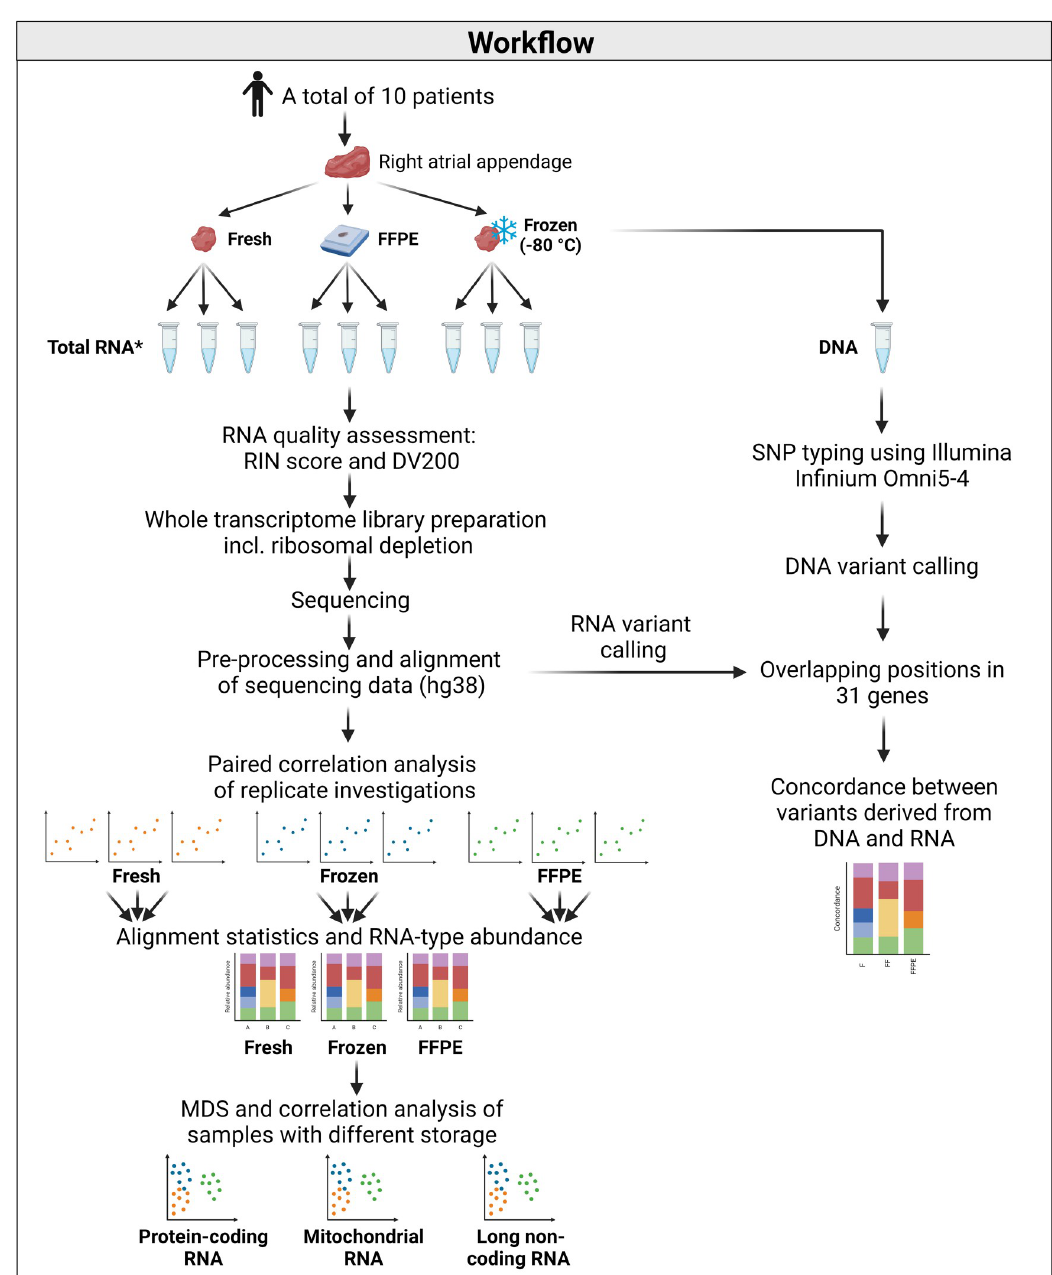
Fig 1. Graphical representation of the workflow. * Only one RNA extraction from each storage condition from patient 5. Abbreviations: DV200: Percentage of RNA fragments > 200 nucleotides, FFPE: Formalin-fixed, paraffin-embedded, RIN: RNA integrity number, SNP = Single nucleotide polymorphism. Created with